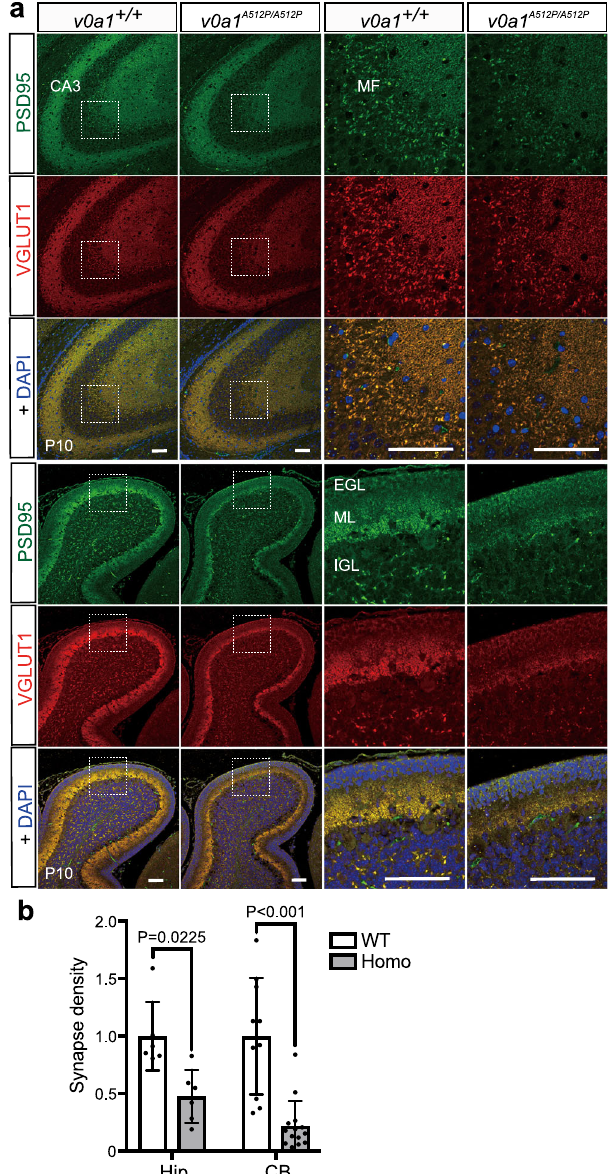
Fig. 5 Excitatory synaptic densities in hippocampal CA3 and cerebellar molecular layers of Atp6v0a1 + / + and Atp6v0a1 A512P/A512P brains. a Immunostaining of a postsynaptic marker PSD95 (green) and a presynaptic marker VGLUT1 (red) in hippocampal CA3 (upper three rows) and in a cerebellar lobule (lower three rows) obtained from Atp6v0a1 + / + (WT) and Atp6v0a1 A512P/A512P (Homo) mice at P10. The regions indicated by dotted boxes in the left two columns of images were expanded in the right two columns. PSD95/VGLUT1 double-positive excitatory synapses (yellow) were decreased in both the hippocampal CA3 and the cerebellar molecular layer in mutant mice. Scale bars, 100 μ m. CA3 hippocampal region CA3, MF mossy fi ber, IGL internal granule layer, ML molecular layer, EGL external granule layer. b Excitatory synaptic density determined as the ratio of PSD95/VGLUT1 double-positive area to the total area was signi fi cantly reduced in both the hippocampus (Hip) and the cerebellum (CB) in Atp6v0a1 A512P/ A512P pups. Data represented as mean values ± standard deviation of six or more measurements. Data in a are representative of three independent experiments. Two way ANOVA with Sidak ’ s multiple comparisons test was used ( b ). Source data are provided as a Source data fi